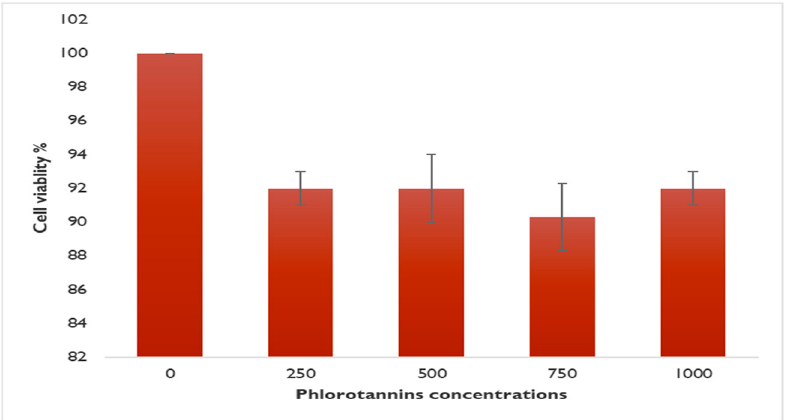
Figure 5. Cytotoxicity of phlorotannins extracted from S. linifolium brown alga on the WPMY1 normal cell line.